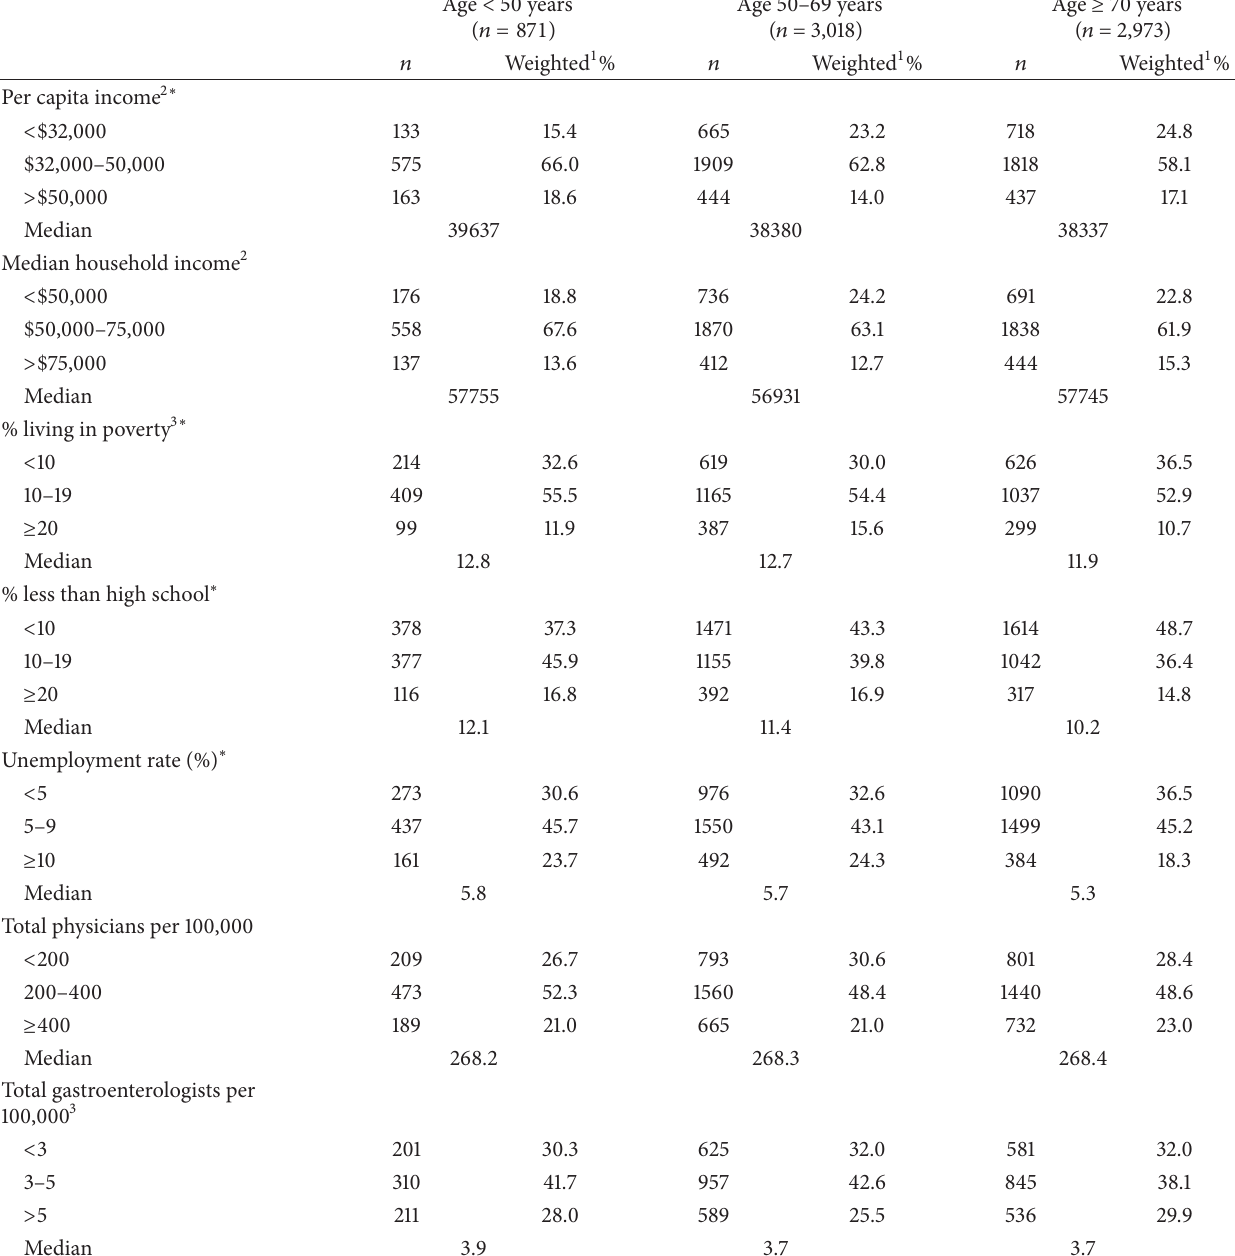
Table 3: County-level socioeconomic indicators of 6,862 patients diagnosed with stages II and III colorectal cancer, 1990–2010, by age at